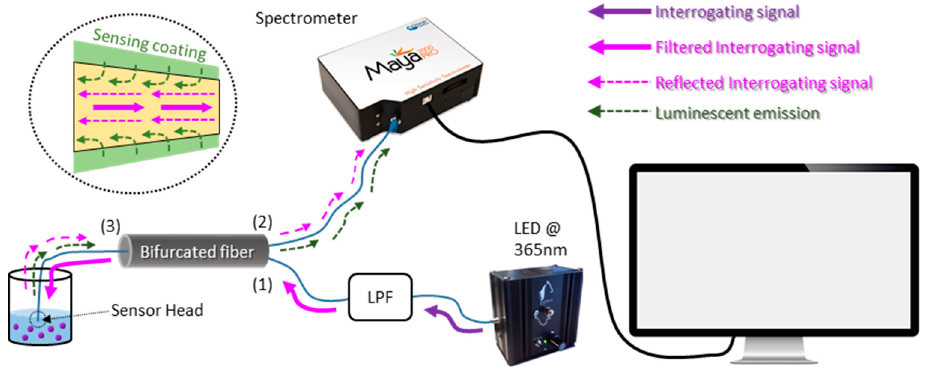
Figure 3. Experimental set-up utilized to characterize the sensor: the blue lines correspond to the optical fibers, while the black one represents the USB cable. (Inset) A scheme of the sensor tip.